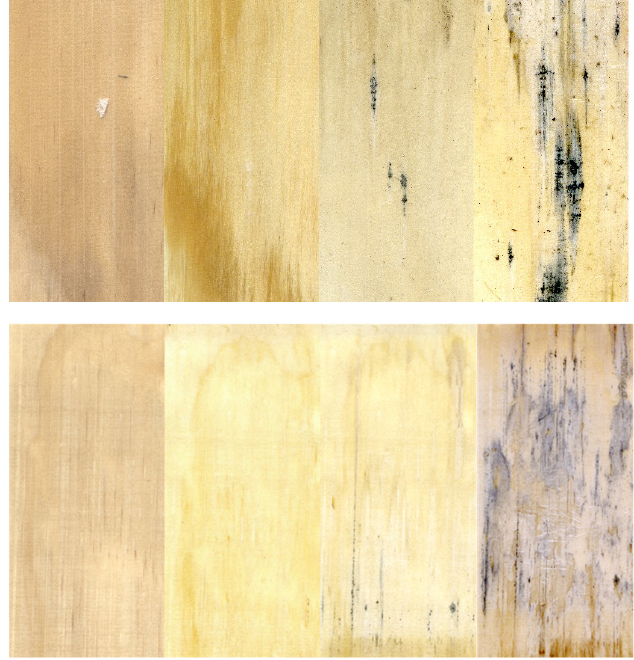
Figure 11. Examples of the same acetylated wood specimen treated with OM and exposed outdoors on a test fence near Corvallis, OR, for 0, 6, 12, and 18 months ( top row ) and a similarly treated sample exposed at Madras, OR, for 0, 6, 15, and 25 months ( bottom row ).